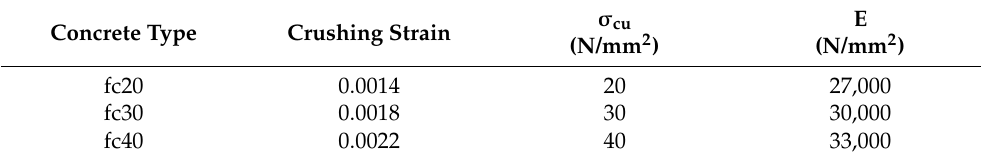
Table 5. Mechanical properties of different concrete plasters.